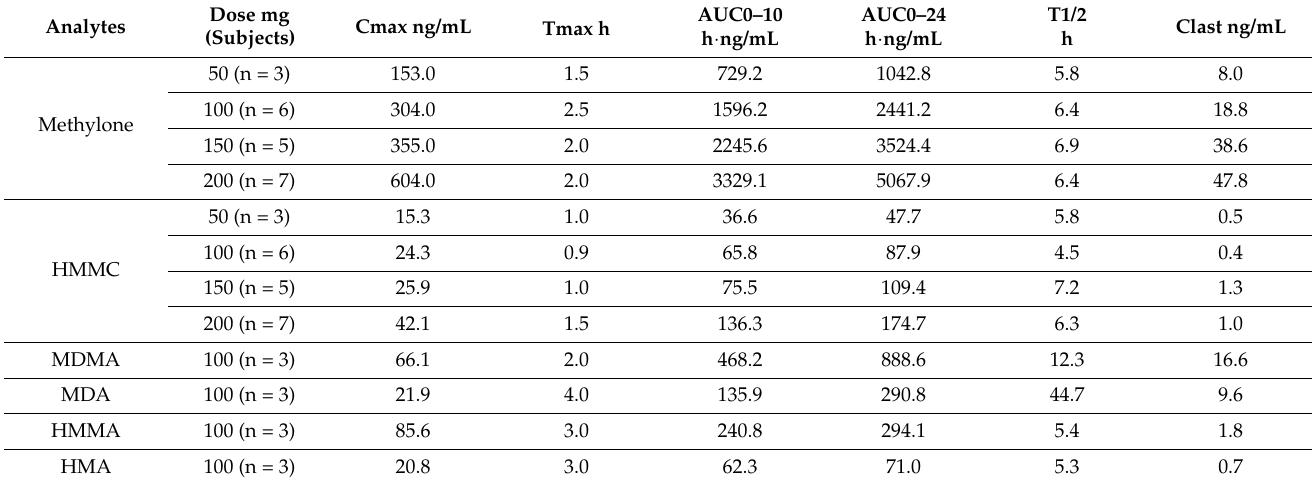
Table 2. Pharmacokinetic parameters for plasma methylone, HMMC, MDMA, MDA, HMMA and HMA.